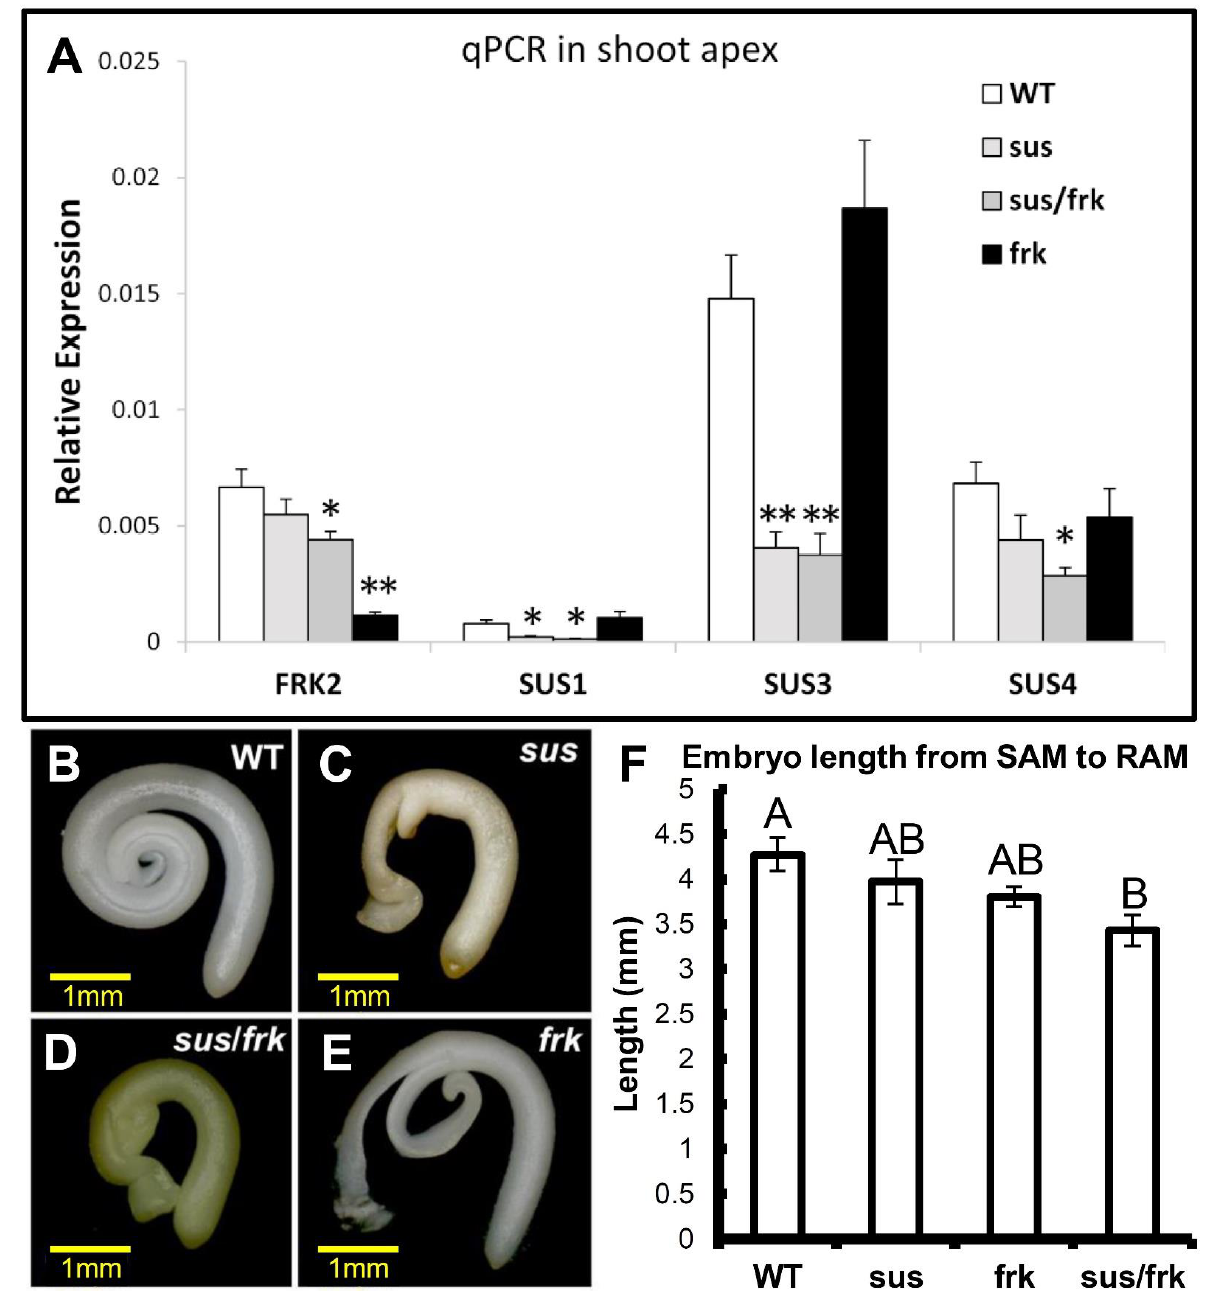
Figure 3. Expression of SUS1,3,4 and FRK2 in sus , frk and sus/frk homozygote plants and the effects of those mutations on embryo morphology. ( A ) The expression of FRK2 and SUS1,3&4 in sus , frk , sus / frk and WT plants was analyzed in RNA extracted from shoot apices. The suppression of the SUS1 and SUS3 genes was similar to that observed among the sus parent plants and the suppression of the SUS4 gene was even stronger. Yet, the suppression of FRK2 in sus / frk was significantly less than that observed for the frk parent. Error bars indicate the standard error ( n = 6). Asterisks indicate a statistically significant difference relative to the WT (* p < 0.05; ** p < 0.01). ( B – E ) Embryos isolated from mature seeds of ( B ) WT, ( C ) sus , ( D ) sus/frk and ( E ) frk . ( F ) Embryo length from the SAM to the root apical meristem (RAM). Error bars indicate the standard error ( n WT = 5; n sus = 5; n frk = 7; n sus/frk = 7). Different letters indicate a significant difference ( t -test, p <